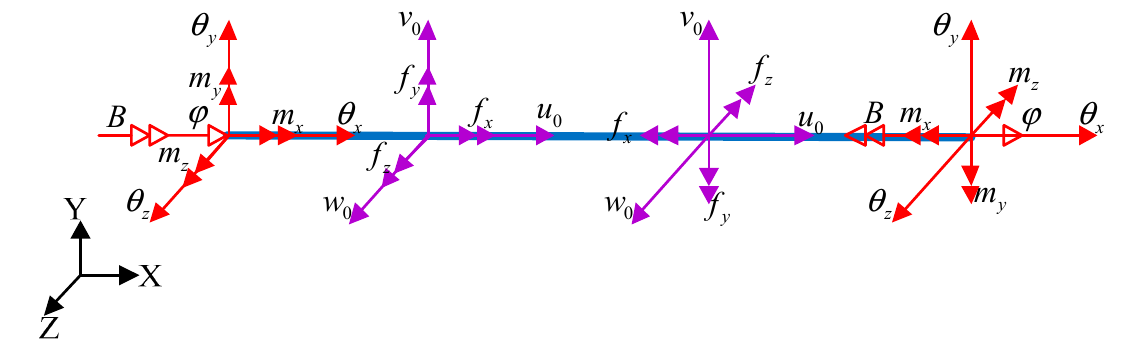
Figure 2. The positive convention for the forces and moments of the beam. According to Figure 2, the seven stress resultants (axial force f x , shear forces f y and f z , bending moments m y and m z , twisting moment m x and bimoment B ) of thin-walled beams with arbitrary closed cross-sections can be expressed as Equation (3), and the explicit der- ivation process form displacement field to stress field is introduced by Zhong et al. [29]. In the aforementioned and the following relations, superscript primes and dots denote the derivatives with respect to axial position x and time t , respectively.